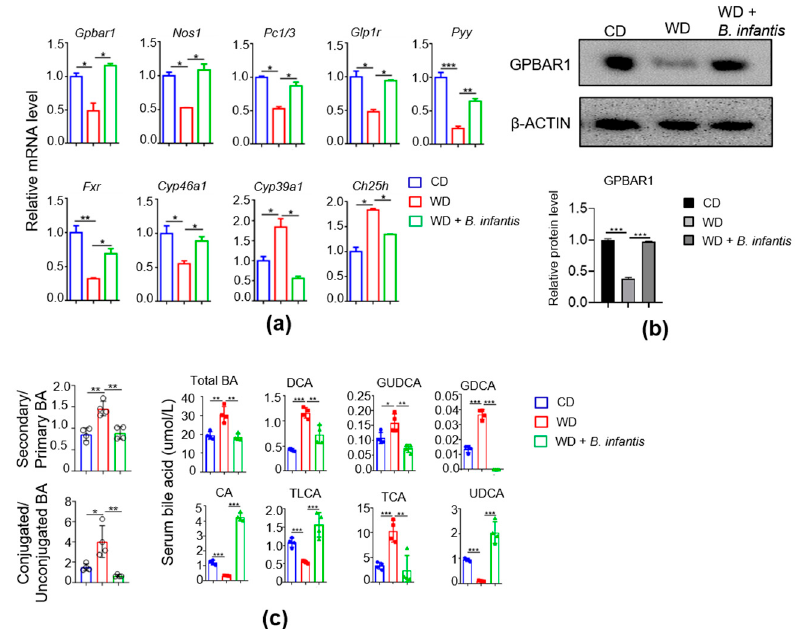
Figure 6. Probiotic B. infantis improved bile acid receptor signaling in the brain reduced by WD: ( a ) Bile acid signaling genes of CD (n = 6), WD (n = 6), and WD fed with B. infantis (n = 4) in mouse brains at the mRNA level; ( b ) The protein level of G-protein coupled bile acid receptor 1 (Gpbar1) in the brain; ( c ) Secondary to primary BA ratio, conjugated to unconjugated BA ratio, and serum bile acid level of CD, WD, and WD fed with B. infantis mice. Data are expressed as means ± SD. One-Way ANOVA multiple comparisons Tukey t -test, * p < 0.05, ** p < 0.01, *** p < 0.001. CD-fed mice compared with WD-fed mice and WD-fed mice compared with B. infantis treated mice.